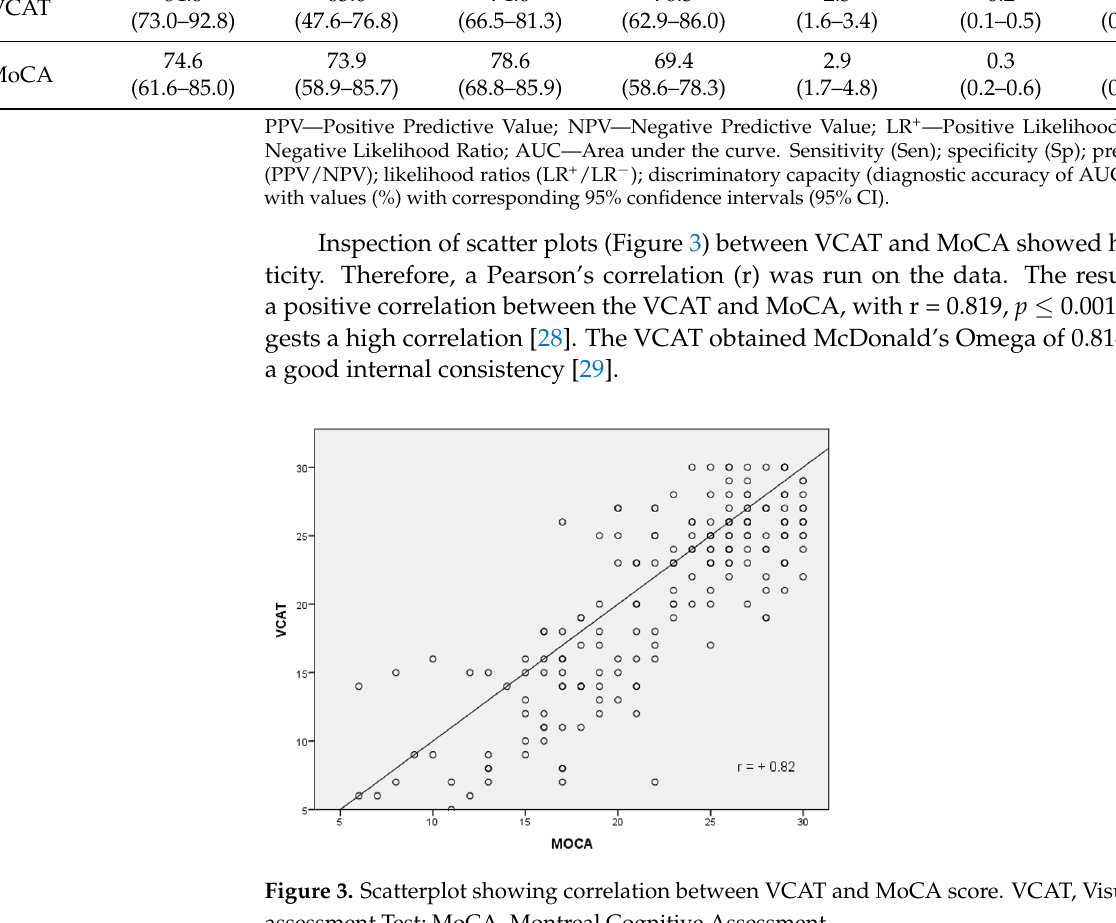
Figure 2. Receiver operating characteristic curves: area under the curve (AUC) for discriminating between MCI and mild dementia (AD + VAD) participants on VCAT and MoCA scores. MoCA Mon- treal Cognitive Assessment, VCAT Visual Cognitive Assessment Test.